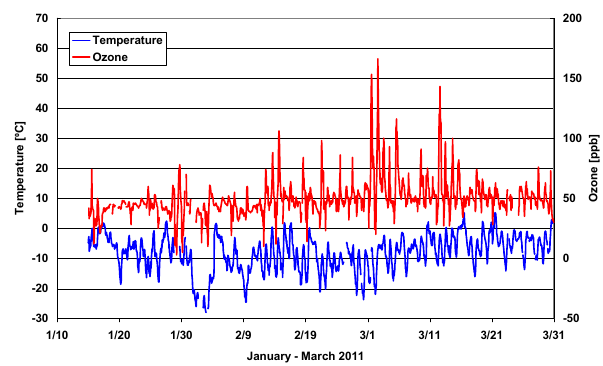
Figure 2. Time series for ozone and temperature based on hourly data at the Boulder site for January–March 2011.